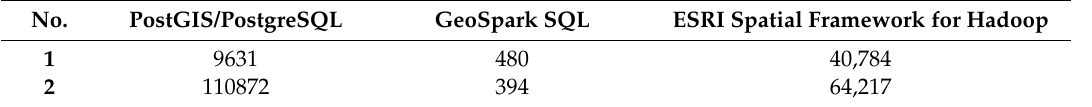
Table 17. Performance of topological queries (in milliseconds).